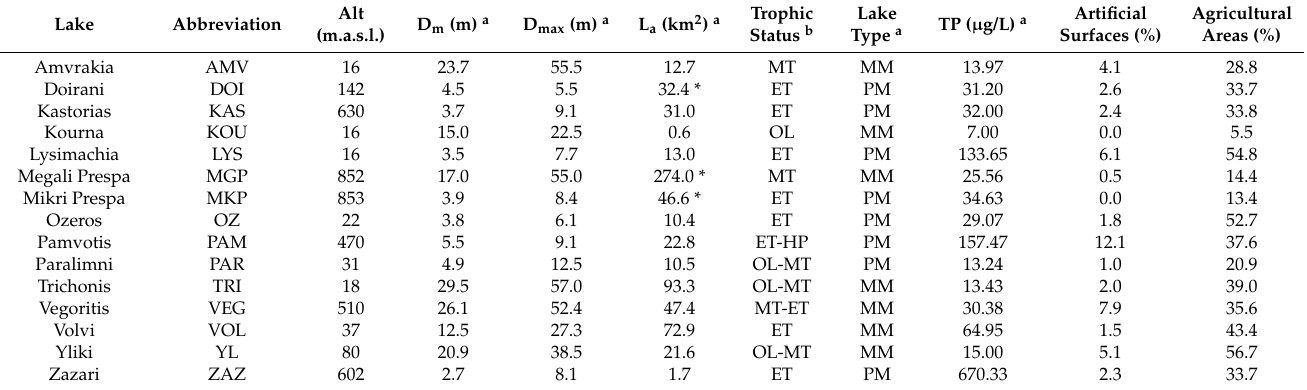
Figure 1. Studied lakes. Abbreviations as in Table 1. Table 1. Limnological characteristics of the studied lakes. Alt: Altitude, D m : mean depth, D max : maximum depth, L a : lake area, TP: Total Phosphorus, OL: oligotrophic, MT: mesotrophic, ET: eutrophic, HY: hypertrophic, WMM: warm monomictic, PM: